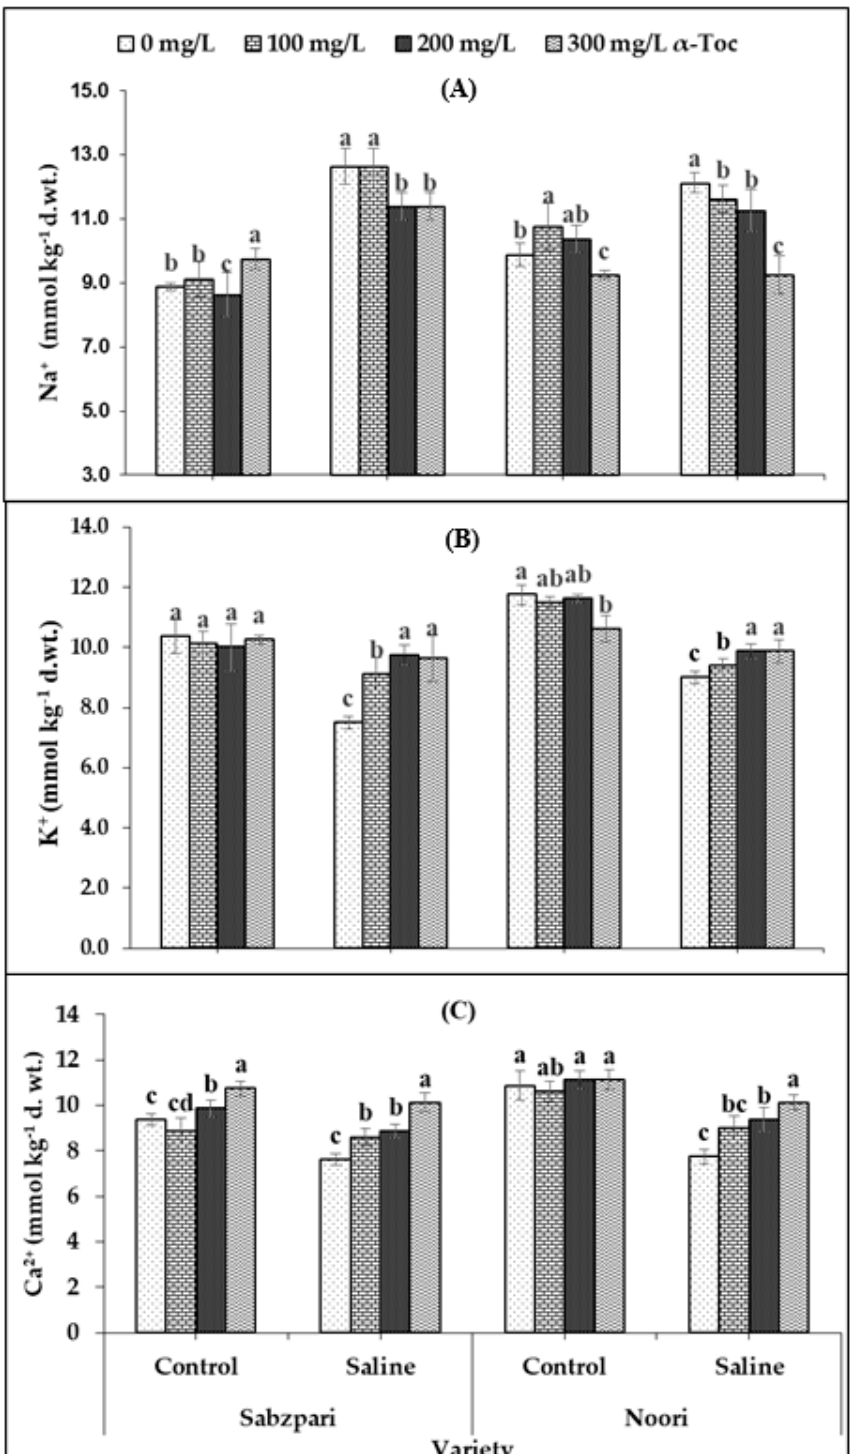
Figure 6. Effect of different levels of α -Toc under saline and non-saline conditions on ( A ) Na + ( B ) K + and ( C ) Ca 2+ ion content of okra varieties. Values represent means ± S.D. Significant differences among row spacing were measured by the least significant difference (LSD) at p > 0.05 and indicated by different letters. S. D. stands for standard deviation.